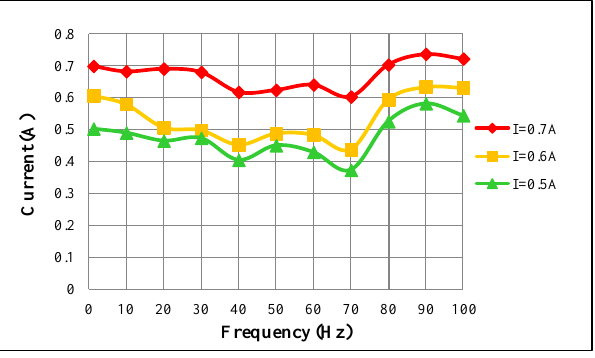
Figure 23. Current-frequency curves of the wireless charging module with pure resistance loads at a 2 mm distance.